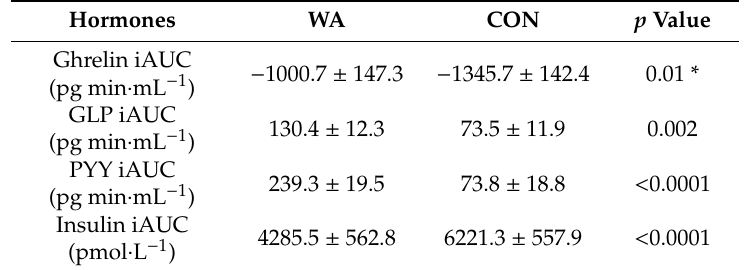
Figure 3. Mean changes in Visual Analogue Scale (VAS) scores as a measure of subjective satiety